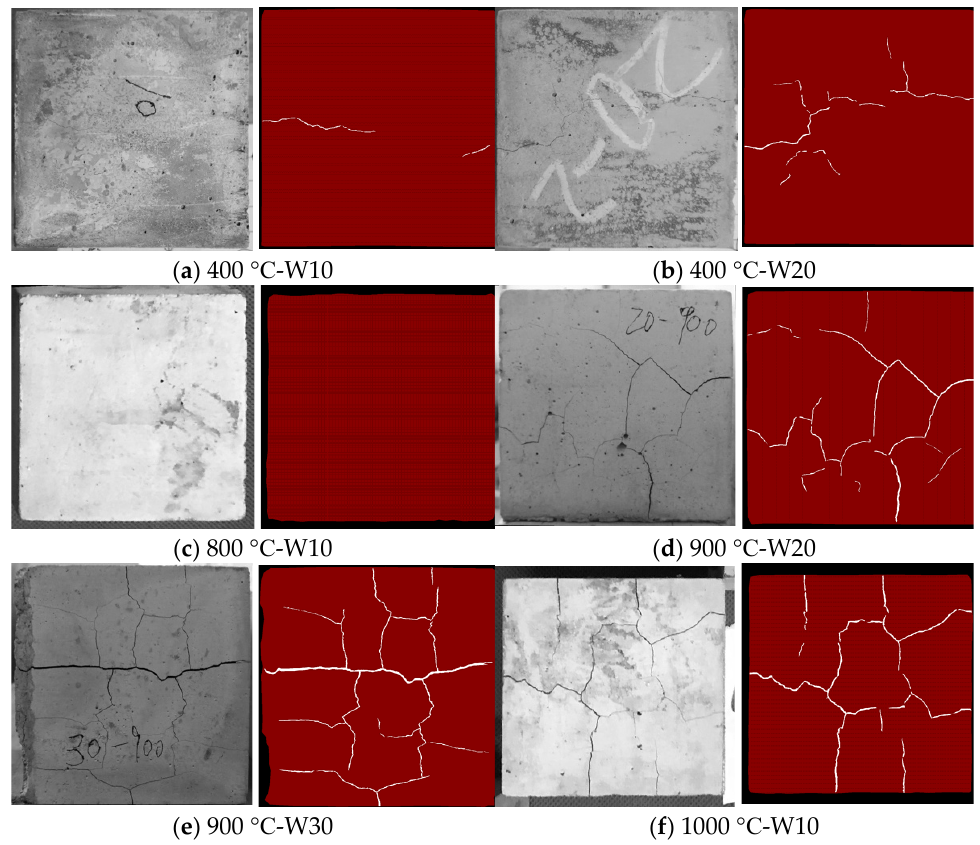
Figure 3. Crack annotation results of the cube specimens with different treatment temperatures and raw material ratios; the treatment temperature and raw material ratio of ( a – f ) are 400 °C ‐ W10, 400 °C ‐ W20, 800 °C ‐ W10, 900 °C ‐ W20, 900 °C ‐ W30, 1000 °C ‐ W10, respectively; left is original image; right is annotation result.